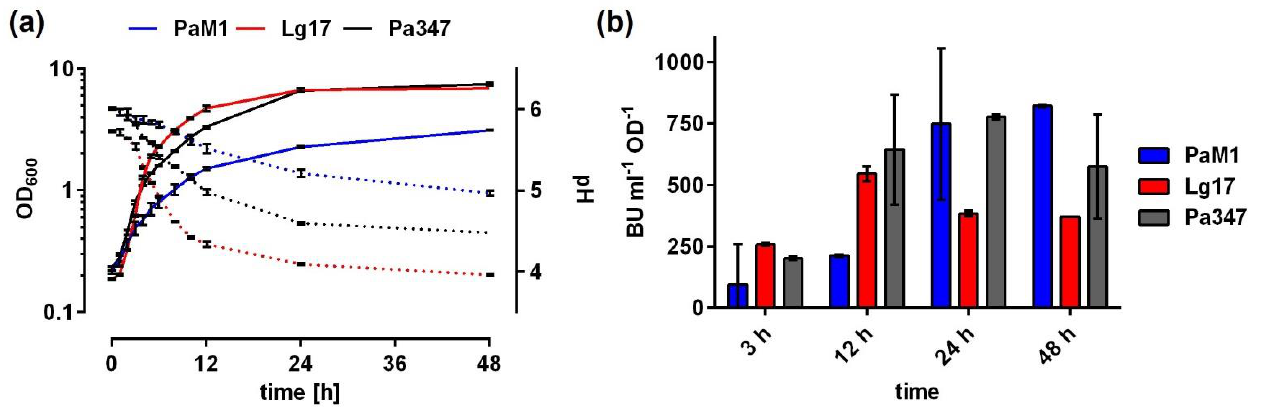
Figure 3. ( a ) Growth (OD 600 ; solid lines) and pH (dotted lines) cultures of P. acidiclactici M1 (blue), L. garvieae 17 (red), or P. acidilactici 347 (black) grown in MRS medium. ( b ) Relative antimicrobial activity (BU ml − 1 OD − 1 ) in supernatants of the cultivations shown in ( a ) collected at the indicated time points. BU ml − 1 were calculated based on the highest dilution showing at least 50% of growth inhibition of the sensor strain ( L. monocytogenes EGDe/pNZ-P help -pHluorin) and were normalized to the OD 600 of the culture at the respective timepoint. All values are mean ± standard deviation of n = 3 independent cultivation.